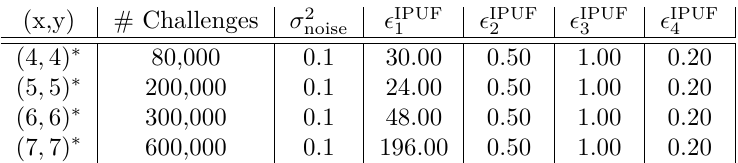
Table 7: Constraints for the first and third step of multi-pass experiments in Table